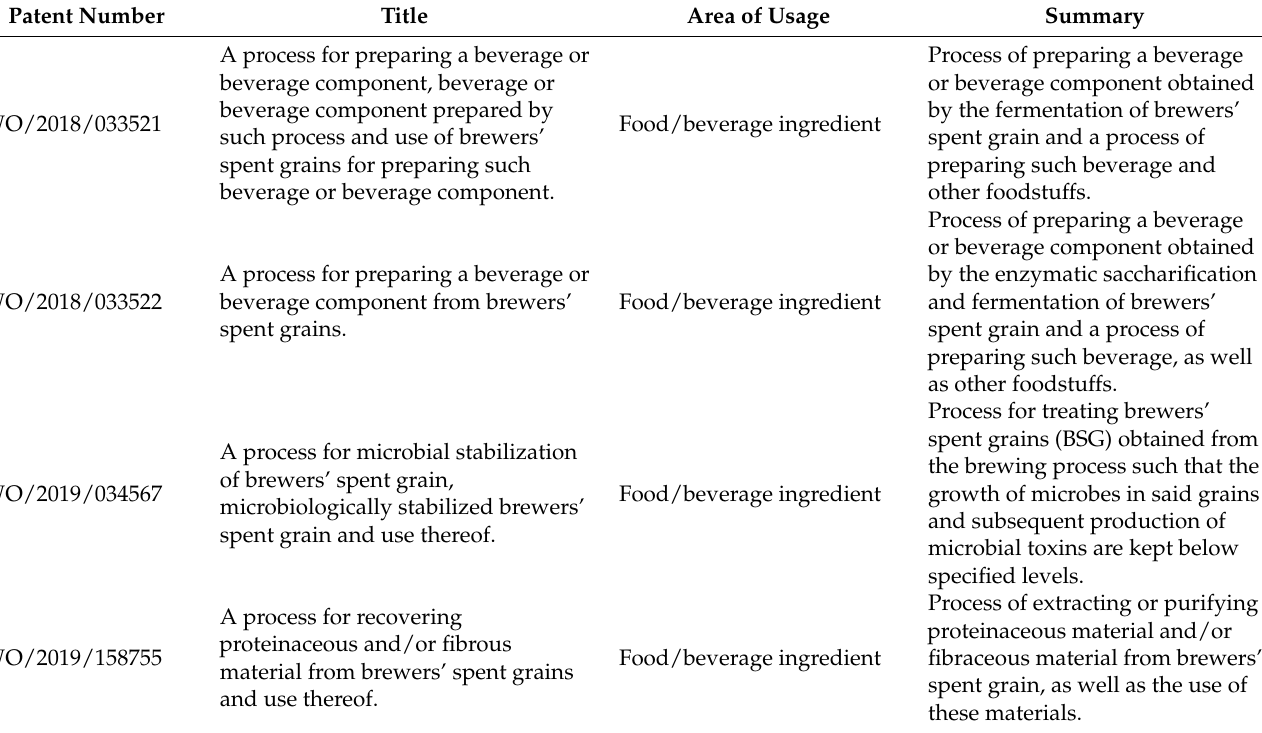
Table 2. Patents regarding the use of BSG ingredients in food and beverage